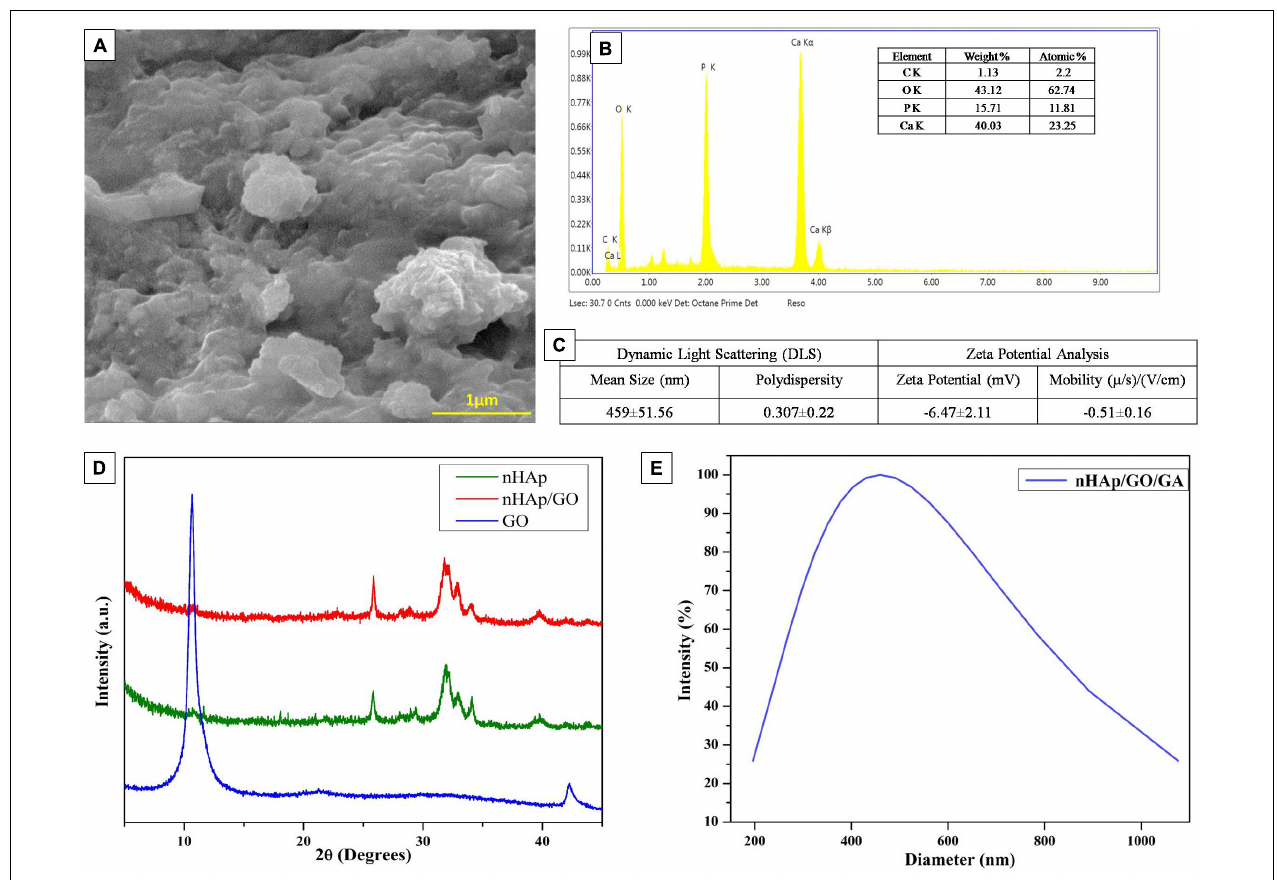
FIGURE 1 | Physico-chemical characterization of as synthesized nHAp-GO nanocomposite:FESEM image (A) , EDS spectra (B) , DLS and zeta potential (C) , XRD spectra (D) , and average particle distribution by DLS (E)